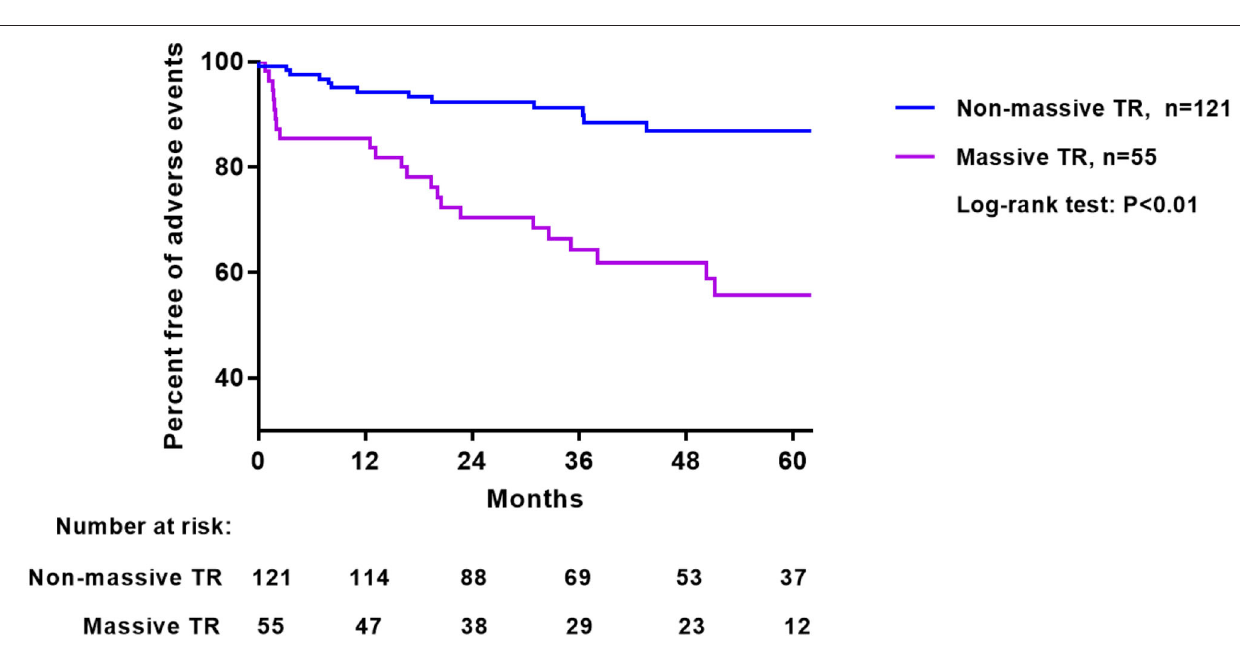
FIGURE 2 | Kaplan-Meier analysis according to tricuspid regurgitation (TR)